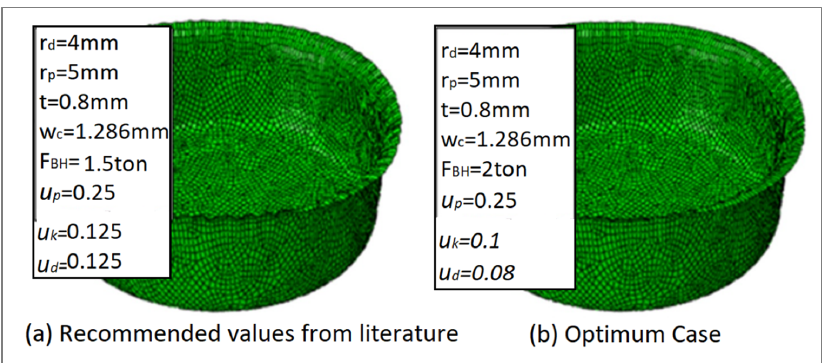
Figure 16. FEA wrinkling formations: ( a ) recommended values from the literature; ( b ) optimum case.